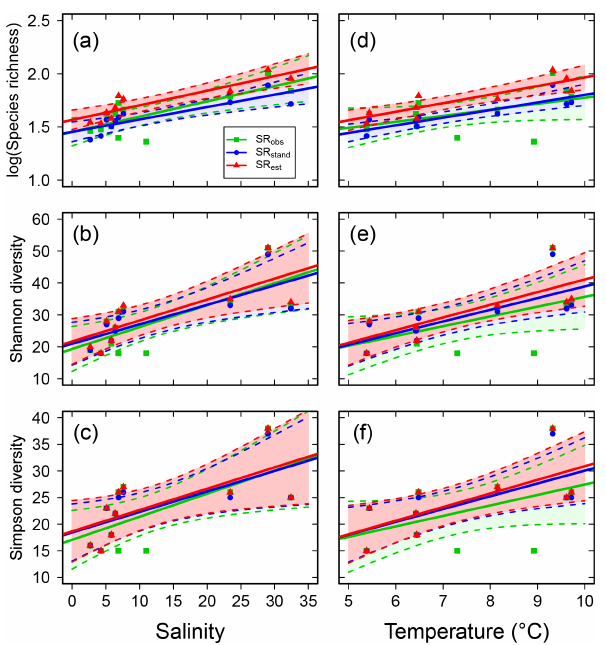
Figure 2. Fish species richness estimates in relation to mean salin- ity (left column) and mean water temperature (right column), with total species richness (log 10 transformed; a and d ), Shannon di- versity (effective number of frequent species; b and e ) and Simp- son diversity (effective number of highly frequent species; c and f ). Each plot shows the observed, standardized and estimated values and, when significant ( P< 0 . 05), the linear regression lines (solid) and 95% confidence intervals (shaded areas surrounded by dashed lines). Please note that data points (Table S7), lines and shaded con- fidence intervals are overlying each other within the panels in some cases. For regression equations and statistics, see Table